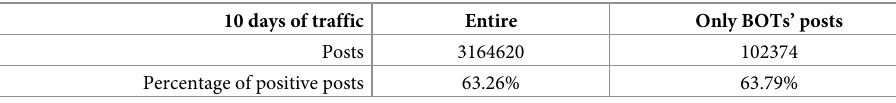
Table 2. “10 days of traffic” sample: Descriptives of the sample obtained with T = 0.35.